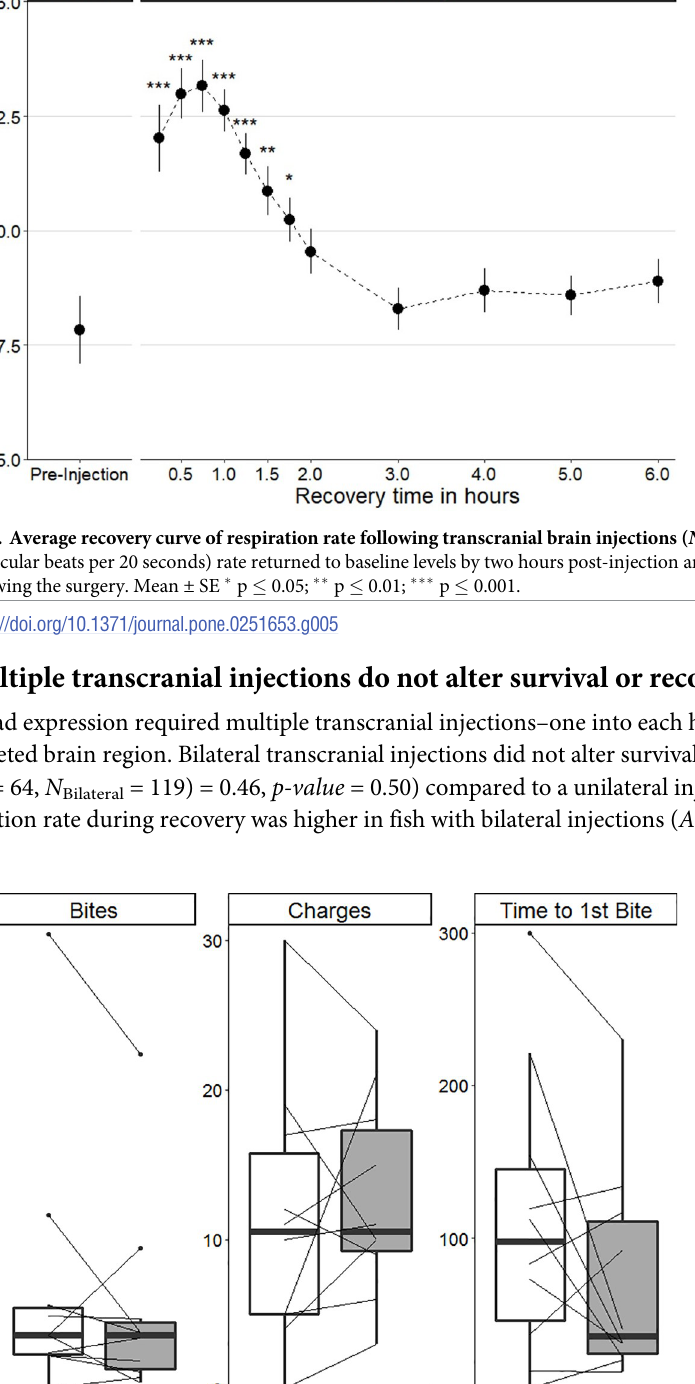
Fig 6. Aggressive behaviors in control fish one day prior to neurosurgery and after direct brain injection of saline ( N = 10). Each line represents an individual showing their change in behavior following saline injection. Outliers beyond 1.5 IQR are shown as individual datapoints. No significant change in aggression was seen in any